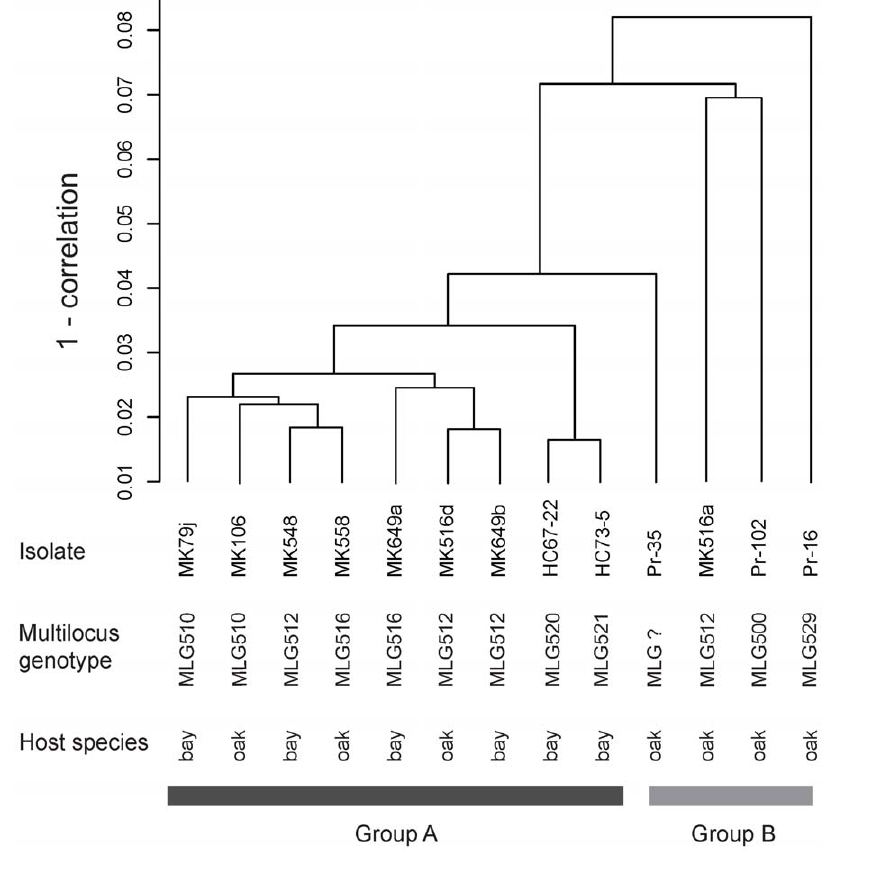
Figure 2. Hierarchical clustering of cDNA samples of Phytophthoraramorum isolates. Thirteen samples were clustered based on their expression patterns of 12,516 genes. Name of isolates, their multilocus genotypes and originating host species are shown. Group A consists of isolates that originate from either coast live oak (oak) or California bay laurel (bay), whereas all isolates in group B originated from coast live oak. Mk516a, Pr-102 and Pr-16 displayed the nwt phenotype. Pr-35, MK516a and Pr-102 had previously displayed the senescence phenotype but grew at the time the analysis was performed. doi:10.1371/journal.pone.0034728.g002 PLoS ONE |